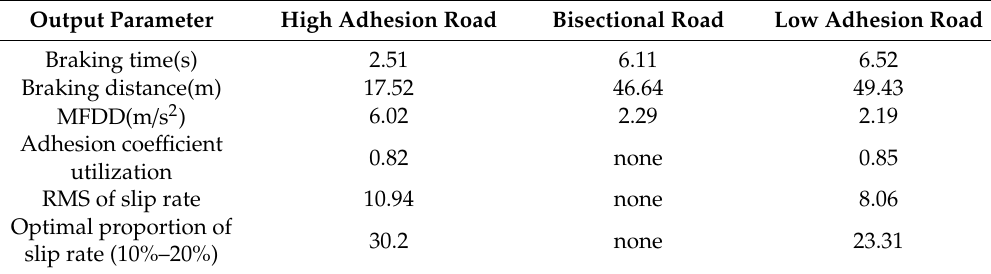
Table 3. Output parameters of road test.